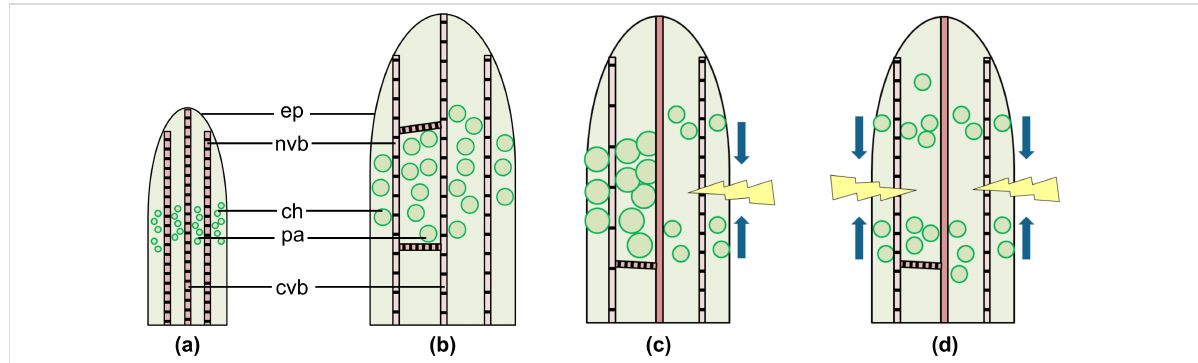
Figure 4: Schematic drawings of intact and damaged leaves. (a) Juvenile leaf, (b) adult leaf, (c) transversal or longitudinal cut, (d) ring incision. Illus- tration of self-sealing (c,d) represents low relative humidity conditions with the arrows indicating the closure of the fissure due to leaf bending (c) or leaf contraction (d). (ep) epidermis with window cells, (ch) chlorenchyma, (nvb) net of peripheral vascular bundles, (pa) parenchyma, (cvb) central vascular bundle. Examples of parenchymatous cells are